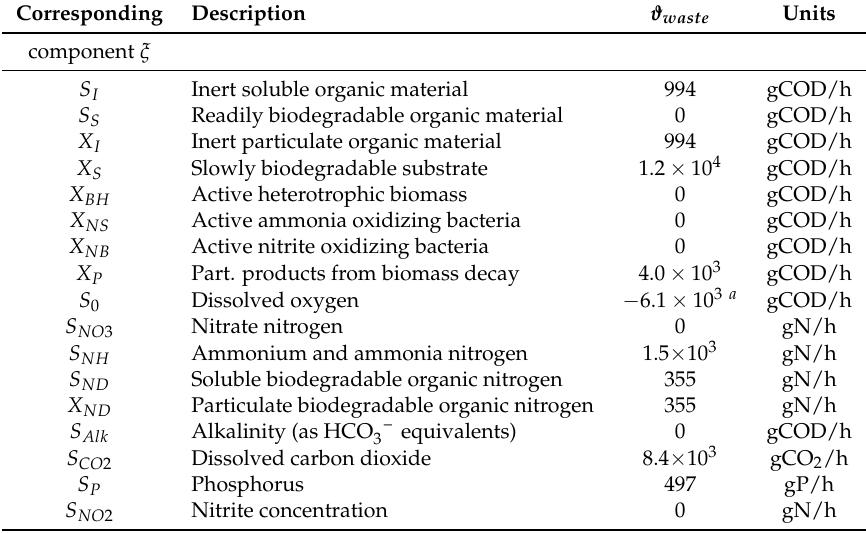
Table 1. Fish waste production rates.